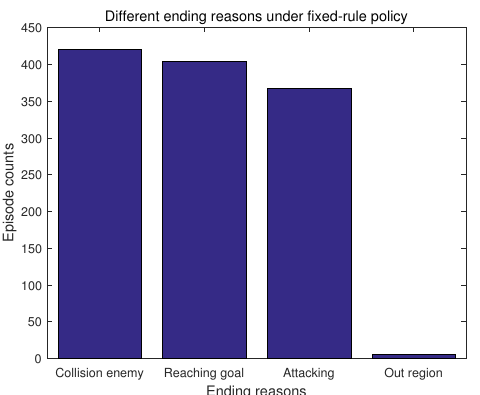
Figure 14. The total numbers of different ending reasons when using the fixed-rule policy.